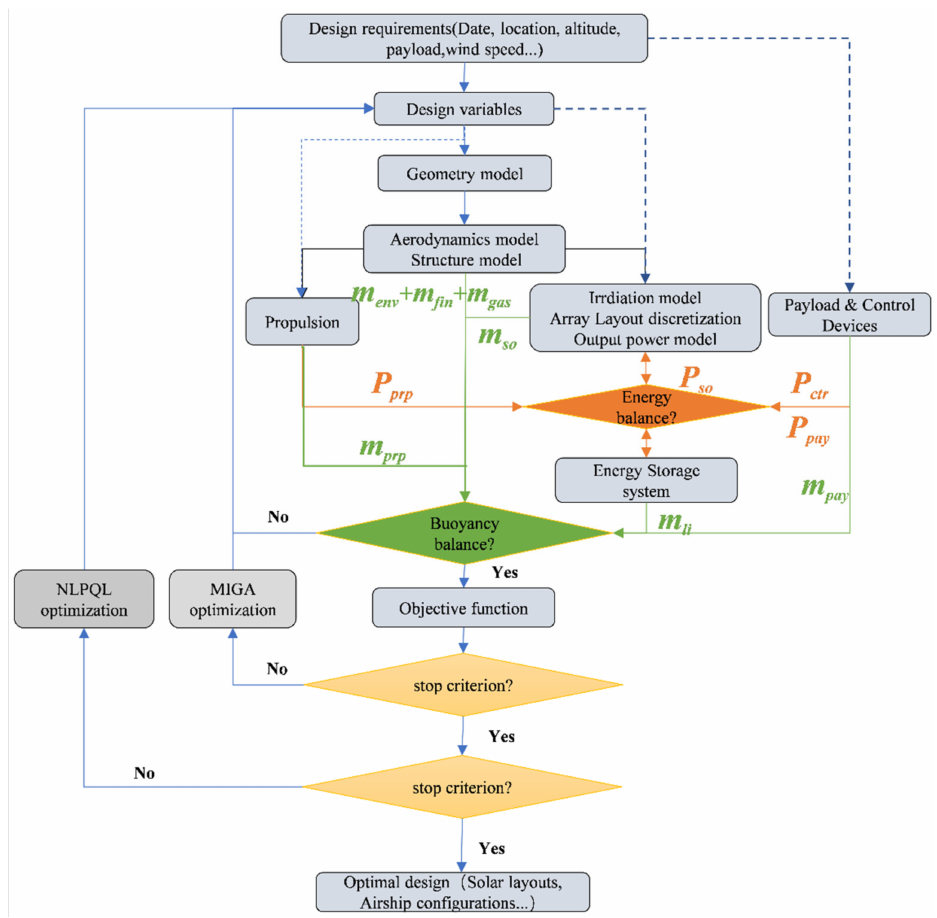
Figure 6. Flowchart of optimization.